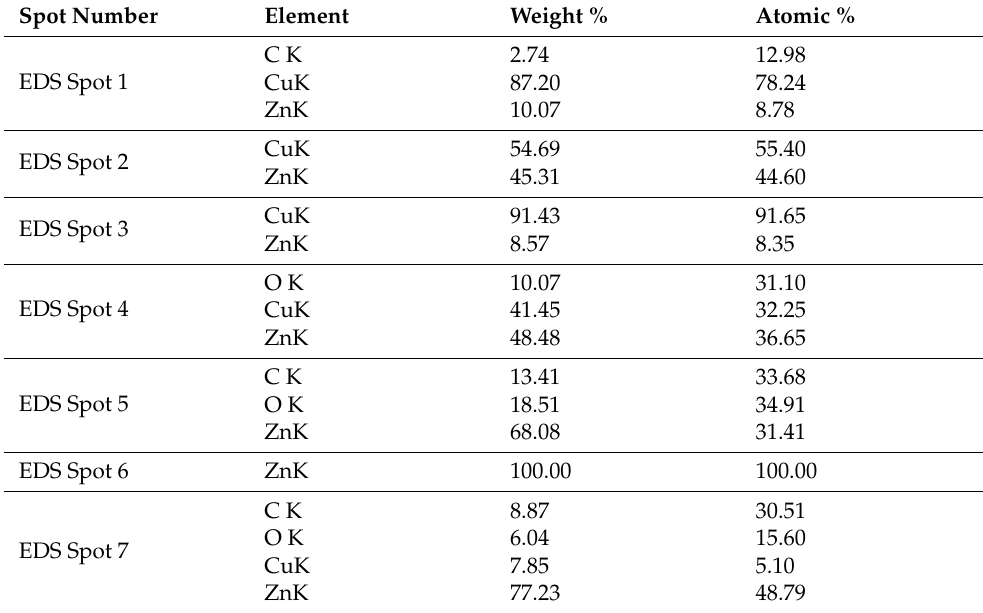
Table 3. EDX of Cu-10%Zn-2%Graphene catalytic layer.